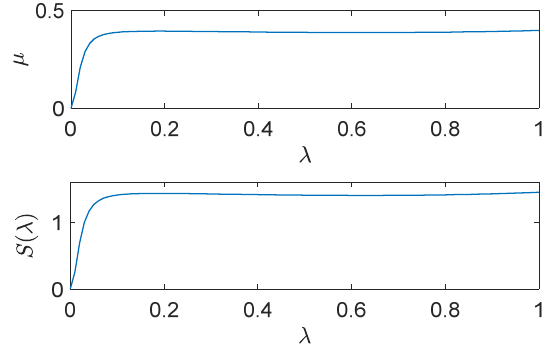
Figure 2. The characteristics µ ( λ ) , S ( λ )